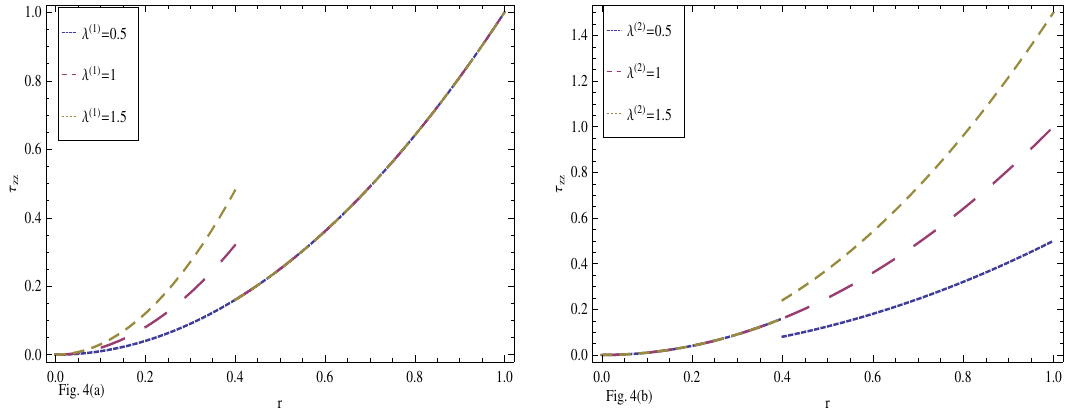
Figure 4. The effect on the normal stresses of the two fluids of ( a ) λ ( 1 ) and ( b ) λ ( 2 ) .